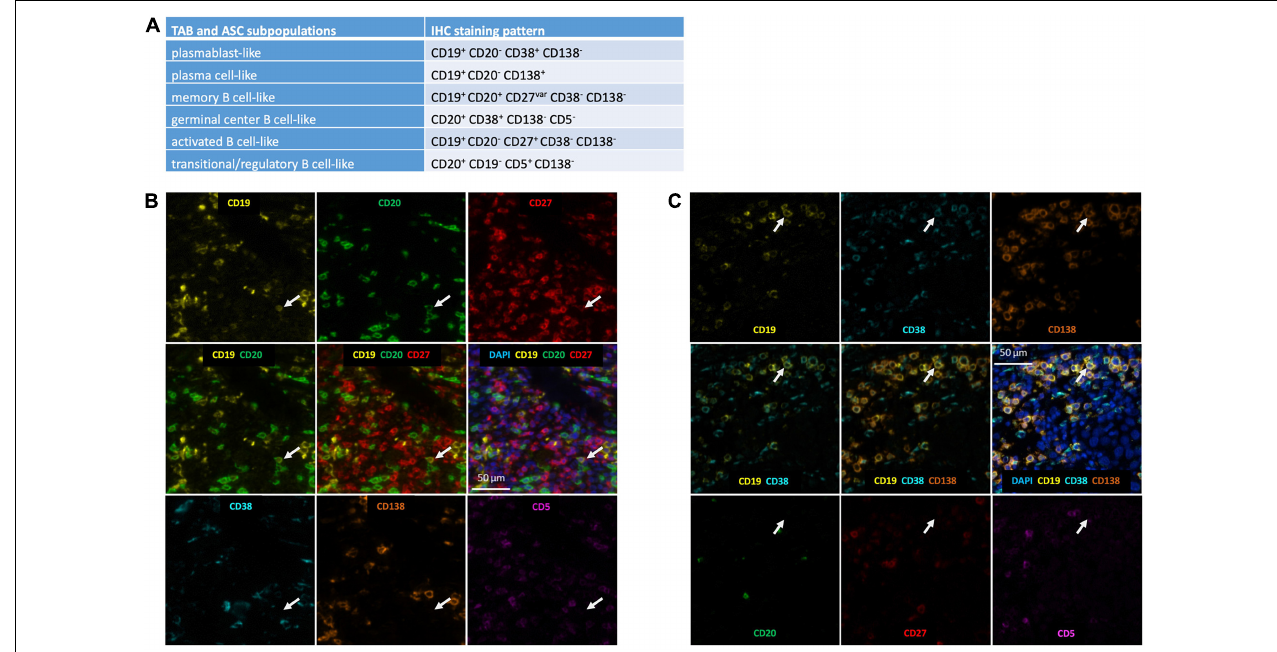
FIGURE 1 | Detection of TAB and ASC subpopulations in human melanoma. (A) Marker combinations used to identify TAB and ASC subpopulations by seven color multiplex immunostaining. Identification of (B) a CD19 + CD20 + CD27 + memory-like TAB and (C) a CD19 + CD38 + CD138 + plasma cell-like ASC. Serial images for the different markers: positive markers are given in the upper row; composite images of positive markers are given in the middle row, together with DAPI nuclear staining in the middle right; negative markers are given in the lower row. Arrows depict the same cell being representative for the respective TAB and ASC subpopulation. Scale bars represent 50 µ